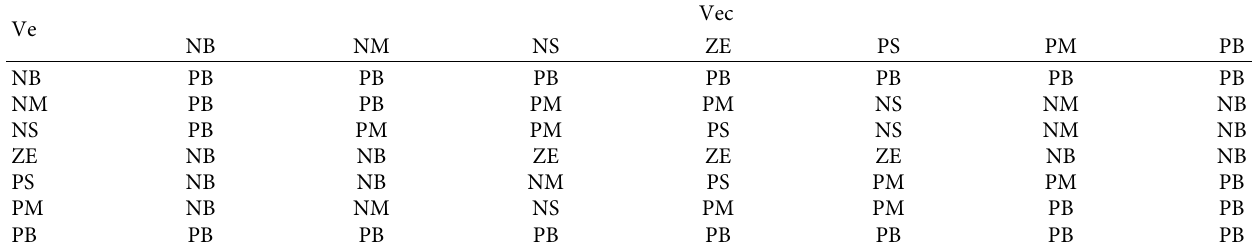
Table 2: Fuzzy rules of Δ